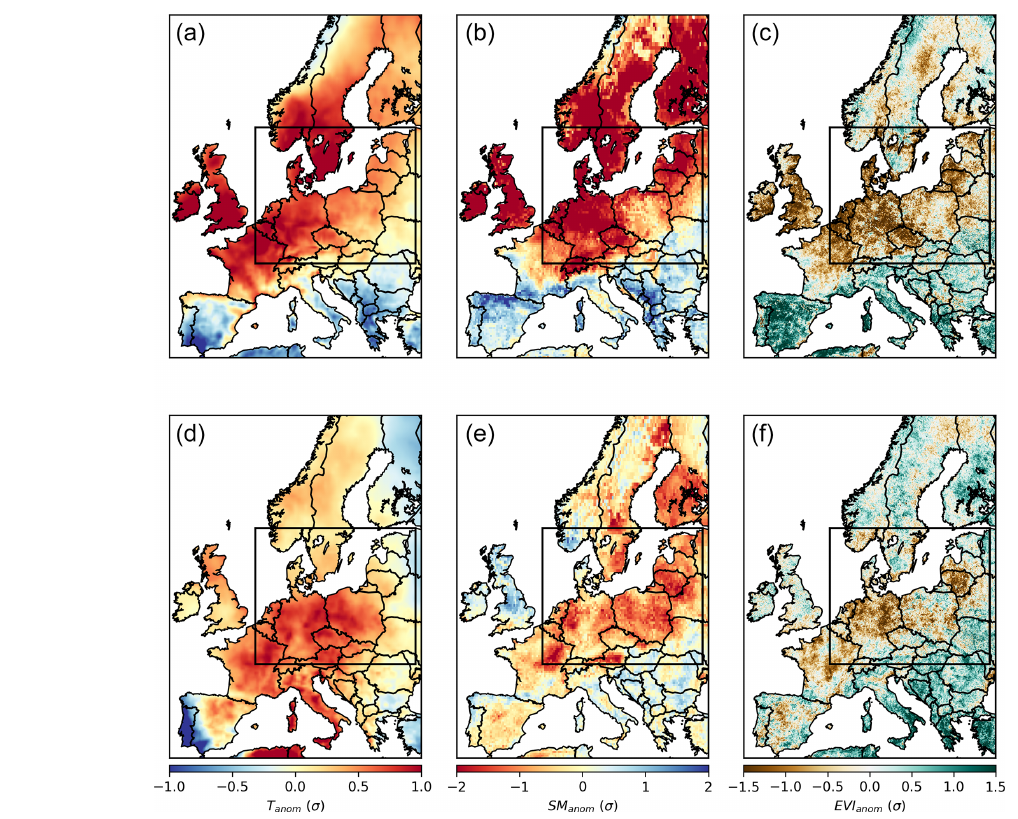
Figure 2. Spatial patterns of temperature ( T anom ), soil moisture (SM anom ), and EVI (EVI anom ) anomalies during summer 2018 (a–c) and summer 2019 (d–f) for the study region. The study region corresponds to a domain with dry and hot conditions in both 2018 and 2019 summers (DH18 and DH19), delimited by the black